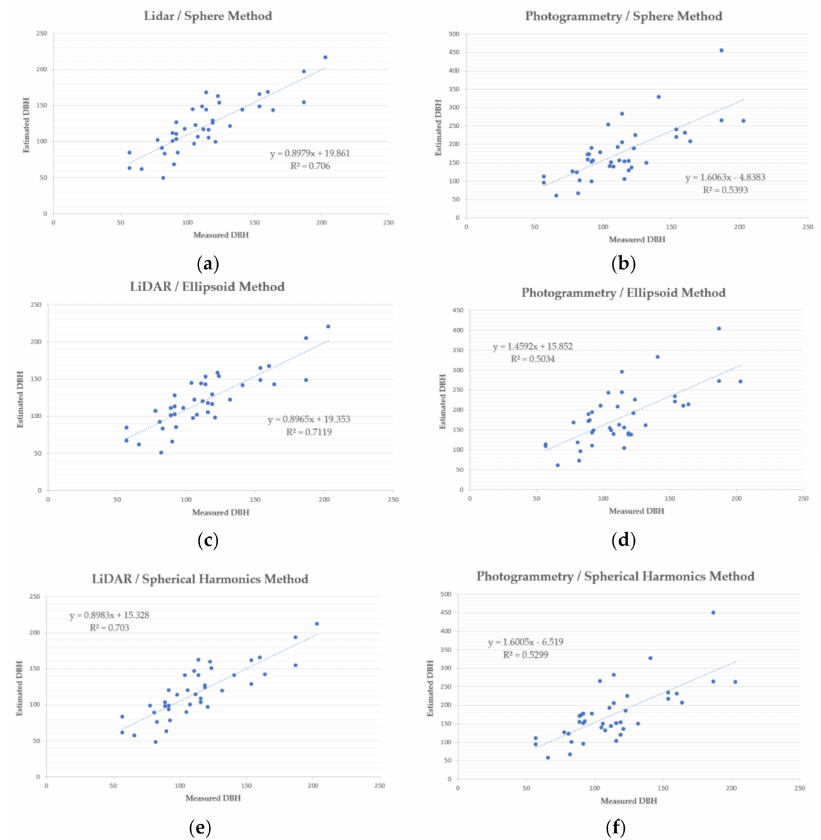
Figure 17. Scatter plot of measured DBH value from field validation with estimated DBH value ( a ) sphere modeling with LiDAR data, ( b ) sphere modeling with photogrammetric data, ( c ) ellipsoid modeling with LiDAR data, ( d ) ellipsoid modeling with photogrammetric data, ( e ) spherical harmon- ics modeling with LiDAR data, and ( f ) spherical harmonics modeling with photogrammetric